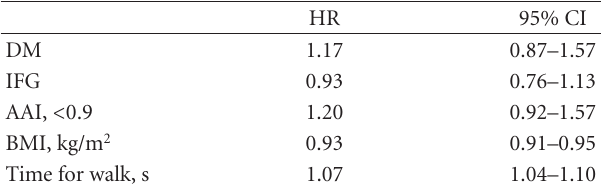
Figure 1: Crude incident hip fracture rate (/1000 person-years) by BMI category for diabetes mellitus, IFG, and normal FG.